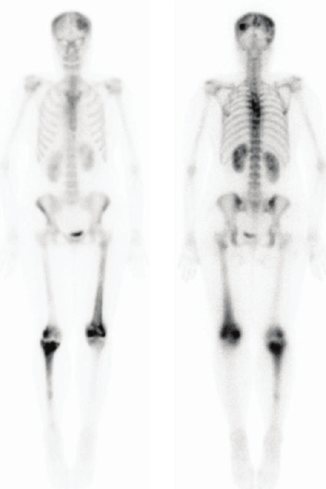
Figure 3: Bone scan showing bone metastasis in skull, dorsal spine, left femur, distal right femur, and proximal right tibia.